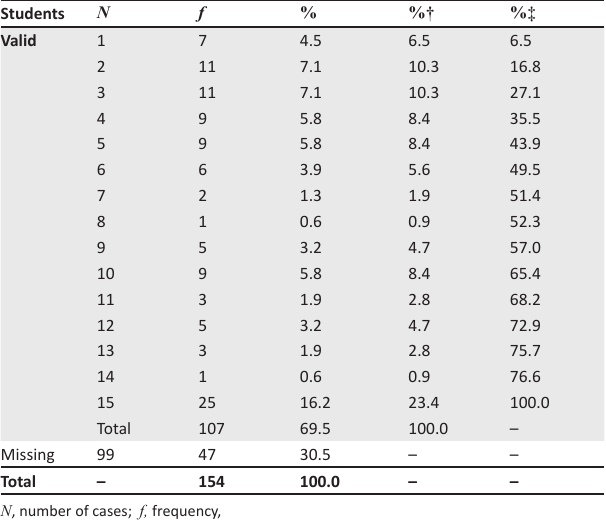
TABLE 7: Students’ performance on intrapartum antiretroviral prophylaxis.